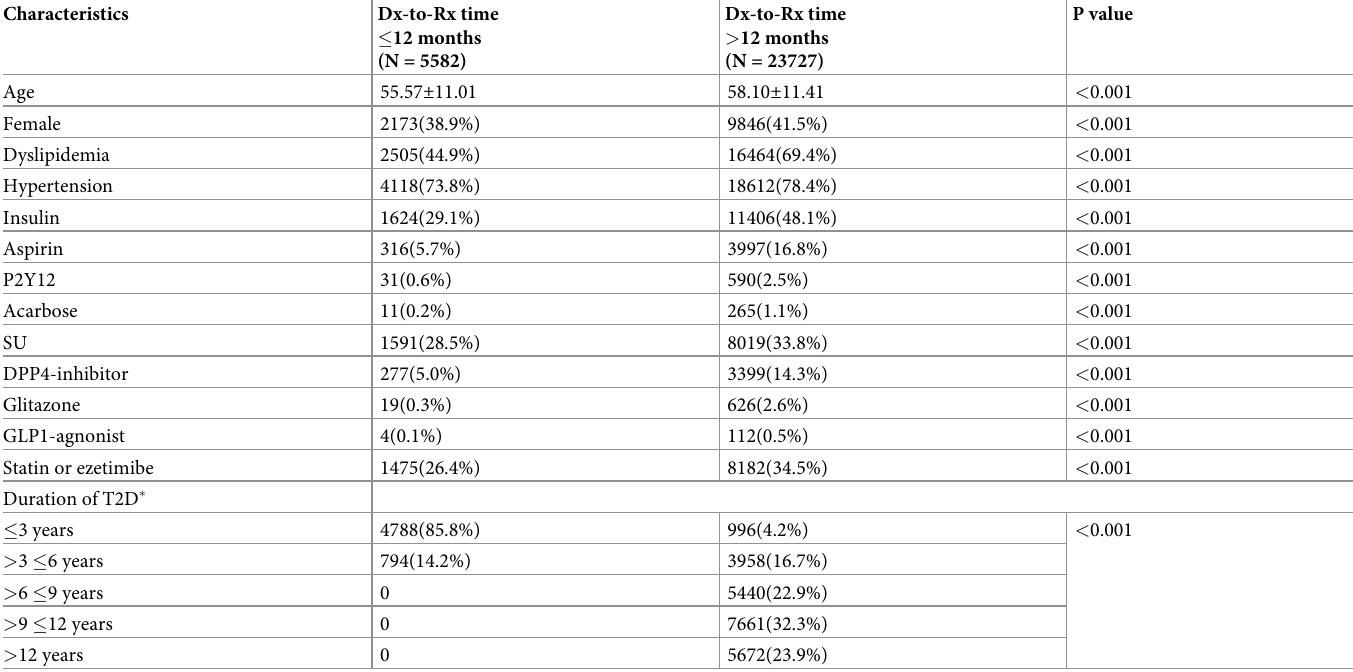
Table 1. Baseline characteristics in patients with Dx-to-Rx time � 12 months versus > 12 months before propensity score matching. Characteristics